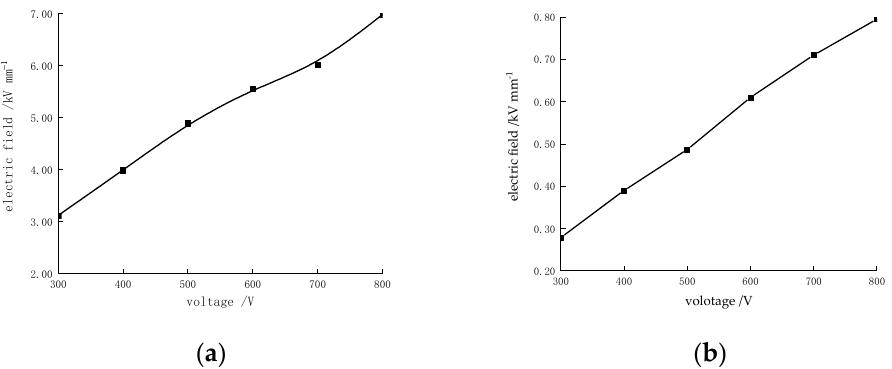
Figure 9. Electric field strength varies with voltage. ( a ) Partial model; ( b ) piezoceramic tube actuator with continuous electrode.